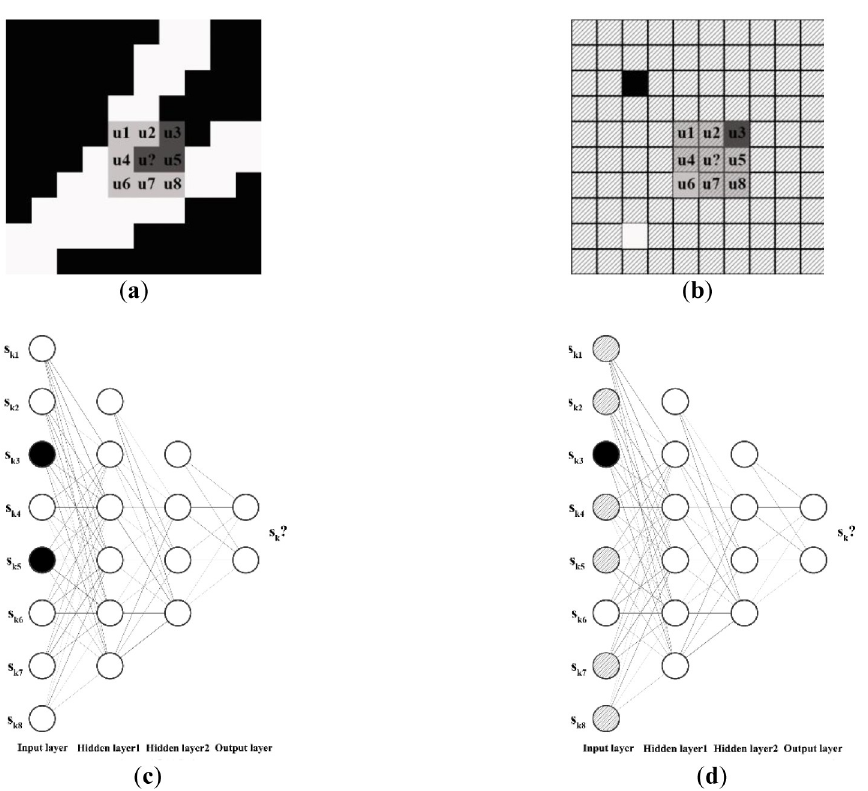
Fig 4. Schematic illustration of facies modeling: (a) training; (b) simulation; (c) training data; (d) simulated data (a white node represents a channel facies value, a black node represents a background value, and a shaded node represents a null